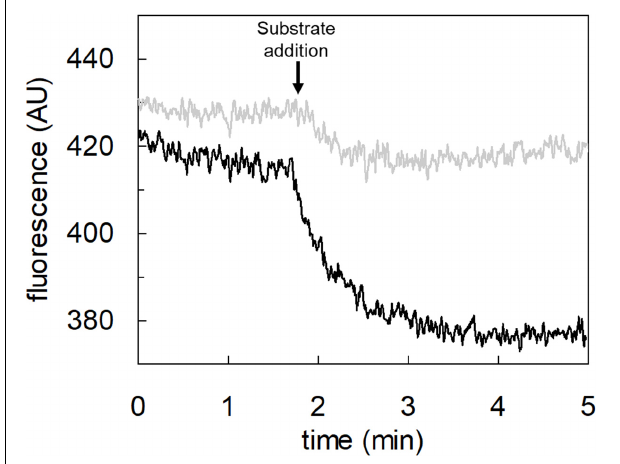
FIGURE 10 | Effect of DEPC on the proton transport by hASCT2 reconstituted in proteoliposomes. Purified hASCT2 was reconstituted in proteoliposomes buffered at pH 7.0, containing 10 mM glutamine and 0.1 mM pyranine, as described in materials and methods. After reconstitution, proteoliposomes were incubated with 10 mM DEPC (gray line) or ethanol (black line) for 5 min at 23 ◦ C and, then were subjected to sephadex-G75 chromatography. The fluorescence measurement was started by adding 150 µ L proteoliposomes to transport buffer (up to 3 mL final volume) composed by 100 mM Na-gluconate and Hepes Tris 20 mM at pH 7.0. After ∼ 2 min as indicated by the arrow, 5 mM glutamate was added to the sample and fluorescence was recorded. The fluorescence signal is indicated as arbitrary units (AU). Results are representative of three independent